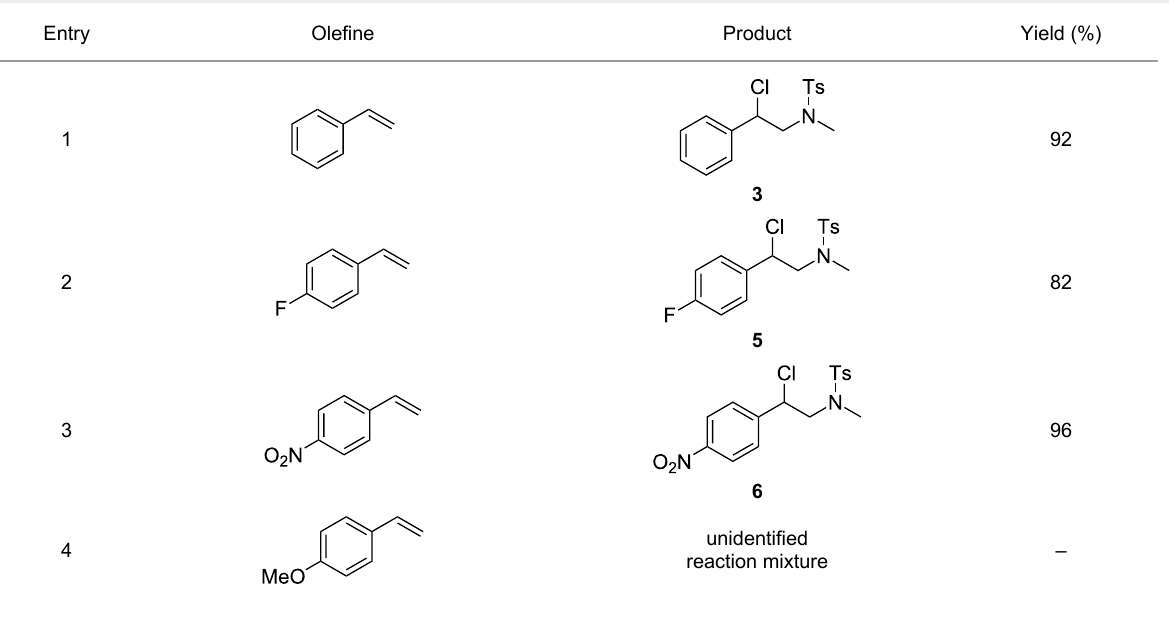
Table 2: Addition reactions of 2a with styrene